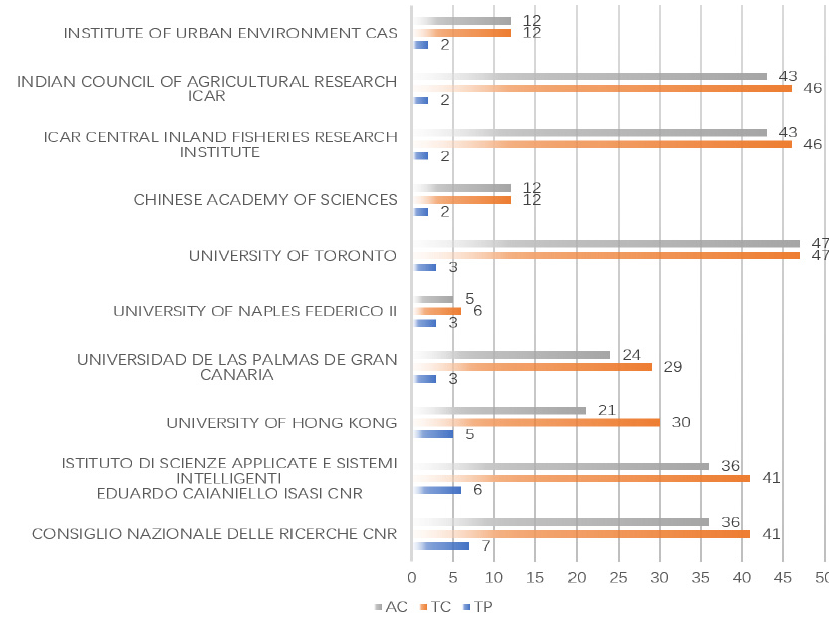
Figure 9. The most contributing